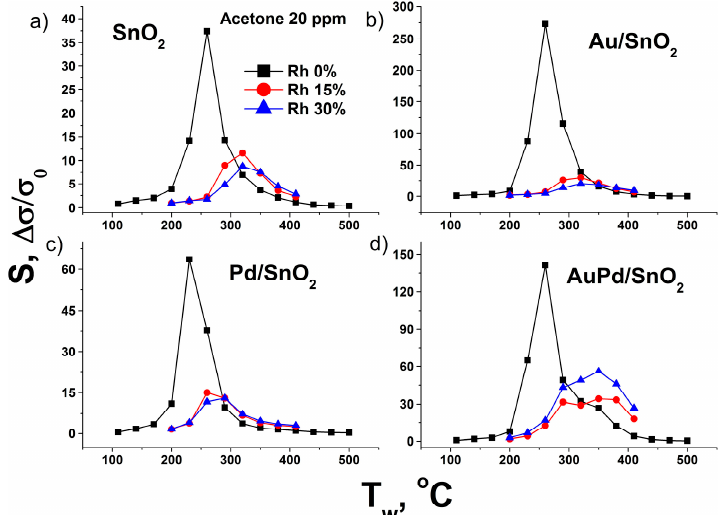
Figure 8. Sensor response dependence on the air humidity for 20 ppm of acetone in the case of ( a ) pure